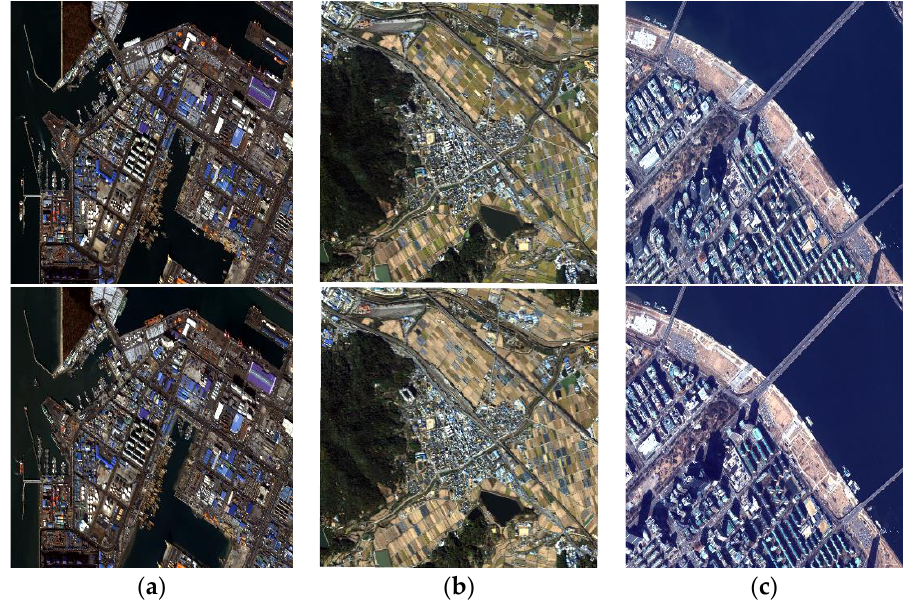
Figure 5. Previous images (top row) and recent images (bottom row) over the study areas from ( a ) Incheon, ( b ) Chilgok, and ( c ) Seoul.